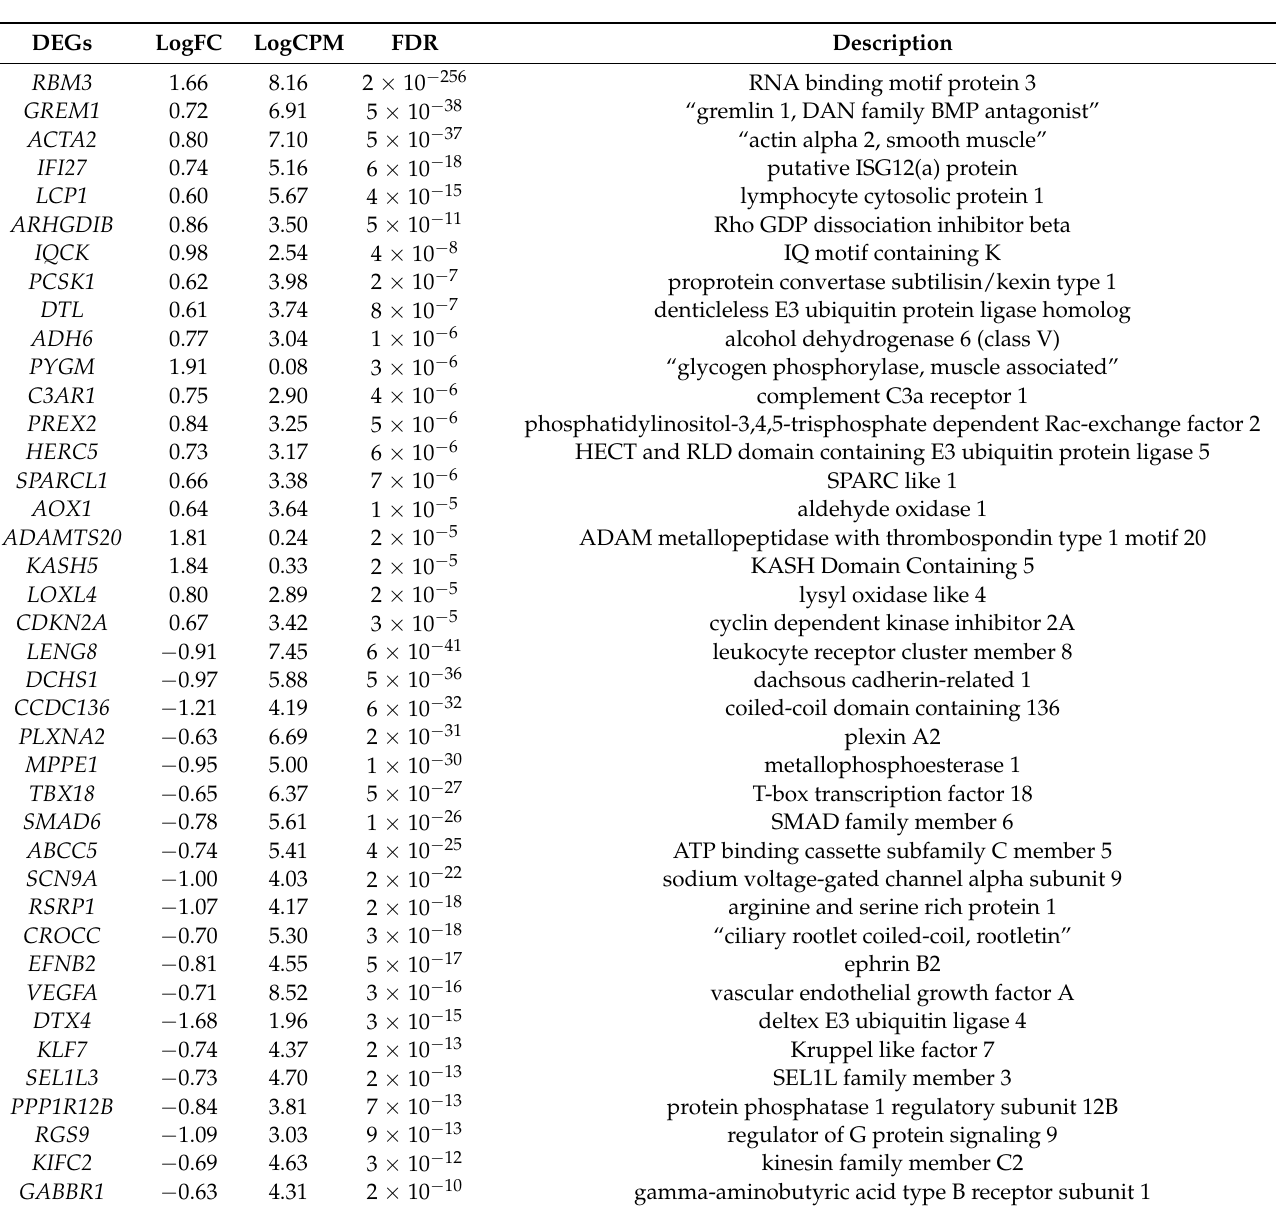
Table 2. Detailed list of top 20 upregulated and downregulated significant differentially expressed genes (DEGs) between heat stress ( n = 3) and control ( n = 3) groups of granulosa cells